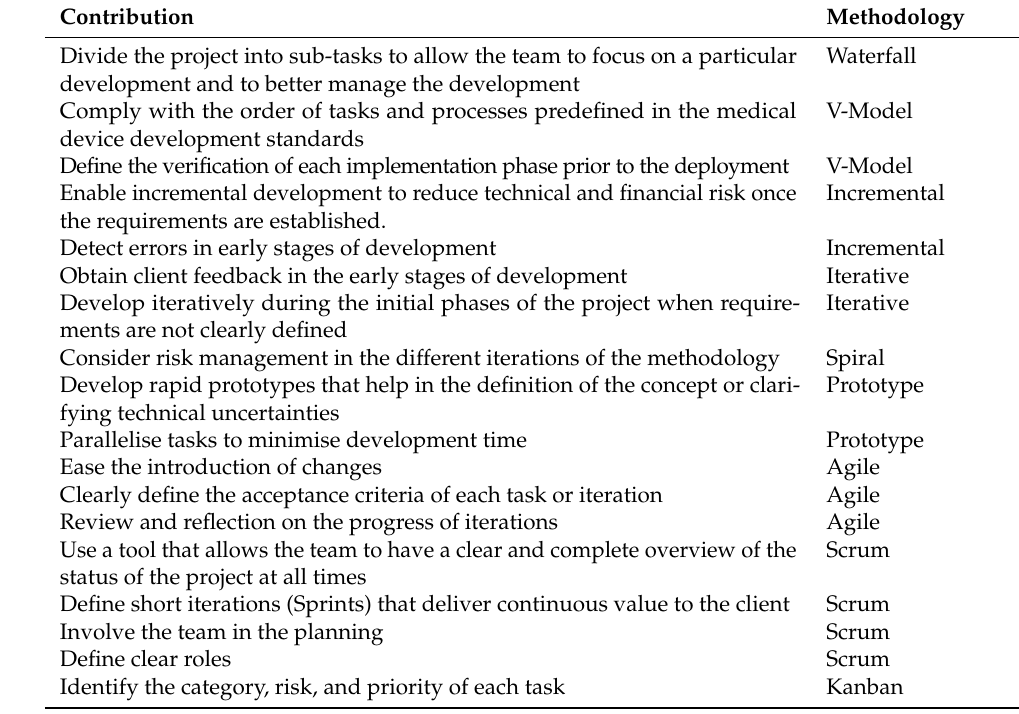
Table 1. Contributions of each methodology to the proposed